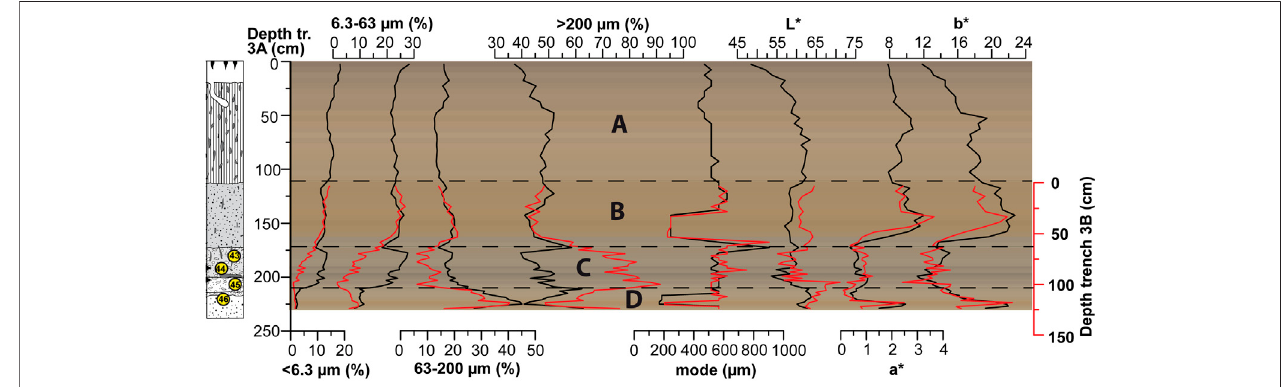
FIGURE 8 | Proxy data of At trench 3A (black line) and 3B (red line) show the grain size distribution in classes < 6.3, 6.3 – 63, 63 – 200, and > 200 µm, and the mode. Further, spectrophotometric color data (L, a*, b*) is shown. Measured colors are plotted in the background using the ‘ drawPro fi le.R ’ R script (Sprafke, 2016; Zeeden et al., 2017). A simpli fi ed sketch of the stratigraphy is shown on the left and the stratigraphic units are indicated by A – D (see legend in Figure 2 ).